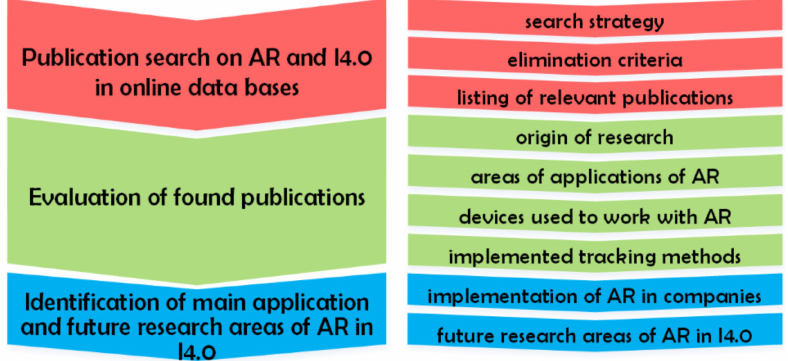
Figure 2. Research